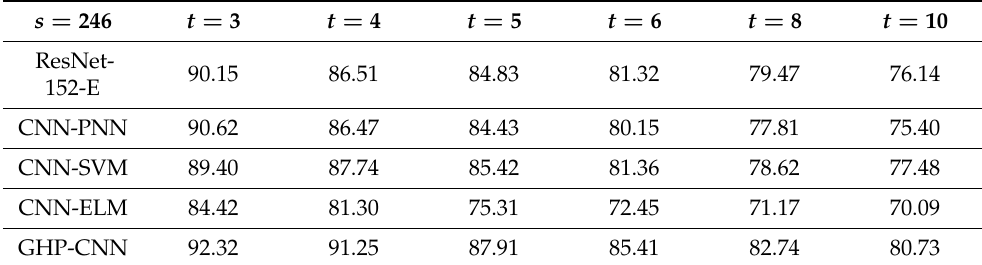
Table 5. Classification accuracy corresponding to different algorithms after the unknown categories with the Caltech-256